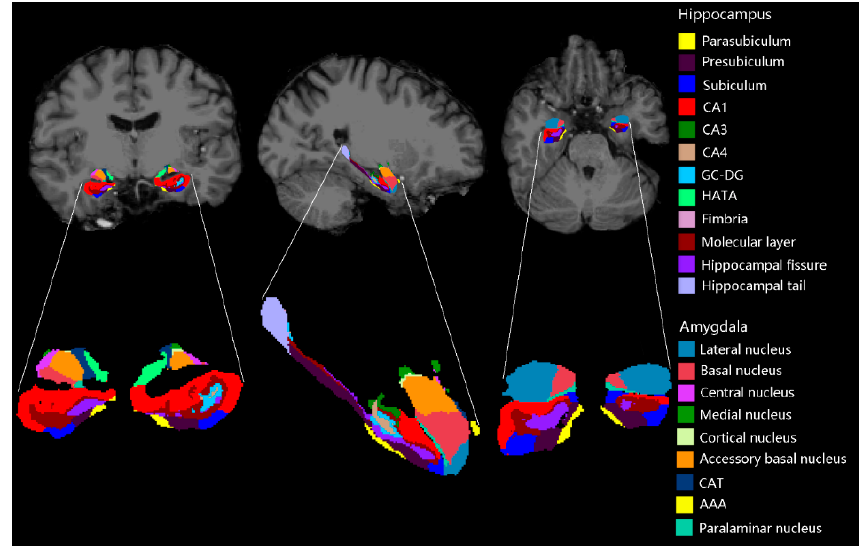
Figure 2. Subregions of the hippocampus and amygdala for one of the subjects.